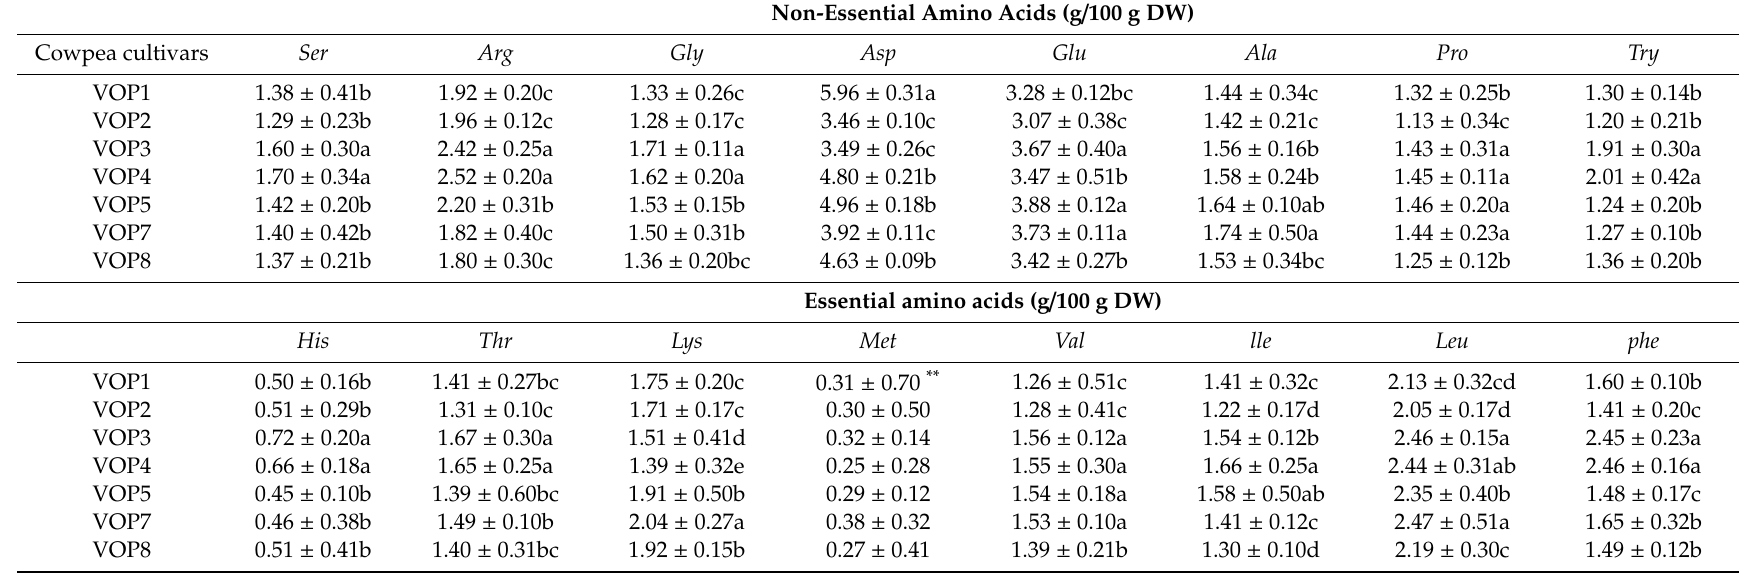
Table 4. Non-essential and essential amino acids in cowpea